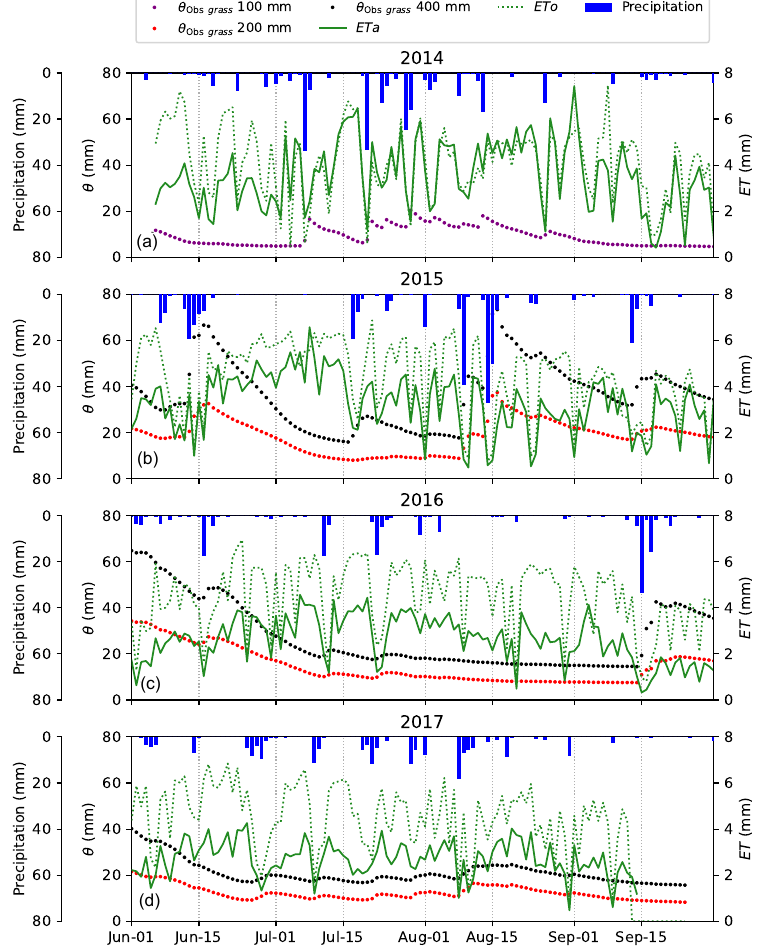
Figure 9. Daily precipitation bars, potential and actual evapotranspiration (ETo and ETa, respectively) and measured soil water content ( θ ) expressed in millimetres at 10 or 20 cm and at 40 cm of depth for the four growing seasons for a better comparison. The daily values of the growing seasons are shown for ( a ) 2014. ( b ) 2015. ( c ) 2016. ( d )